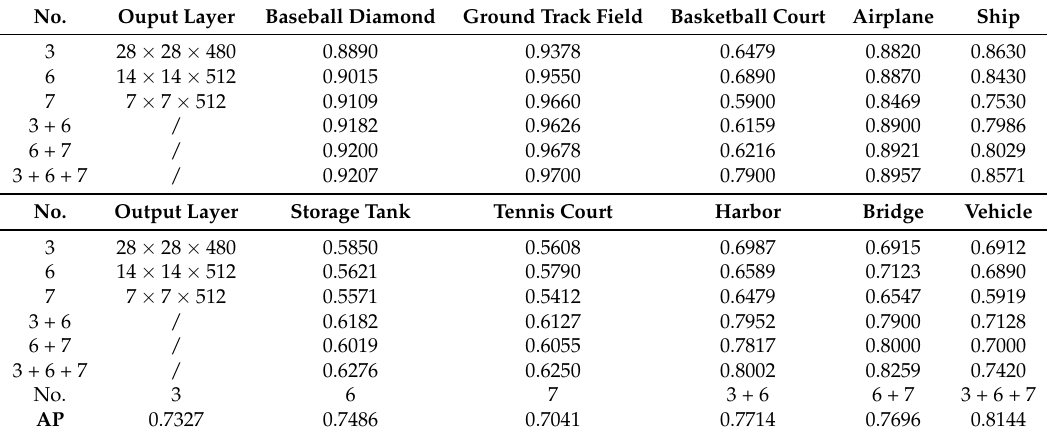
Table 3. The precision of three intermediate layers for the NWPU VHR-10 dataset.